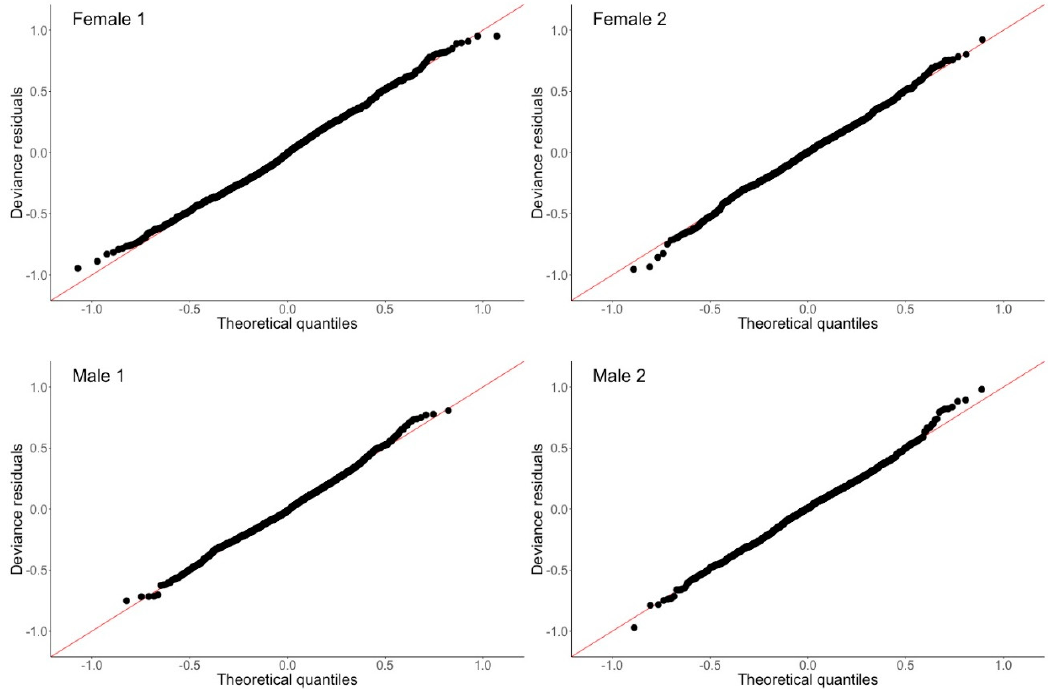
Figure 4. Frequency histogram for R 2 values from the GAM model for each participant in the sample (n = 316). The dashed line represents the mean R 2 value for the whole sample (R 2 = 0.82, SD = 0.09).